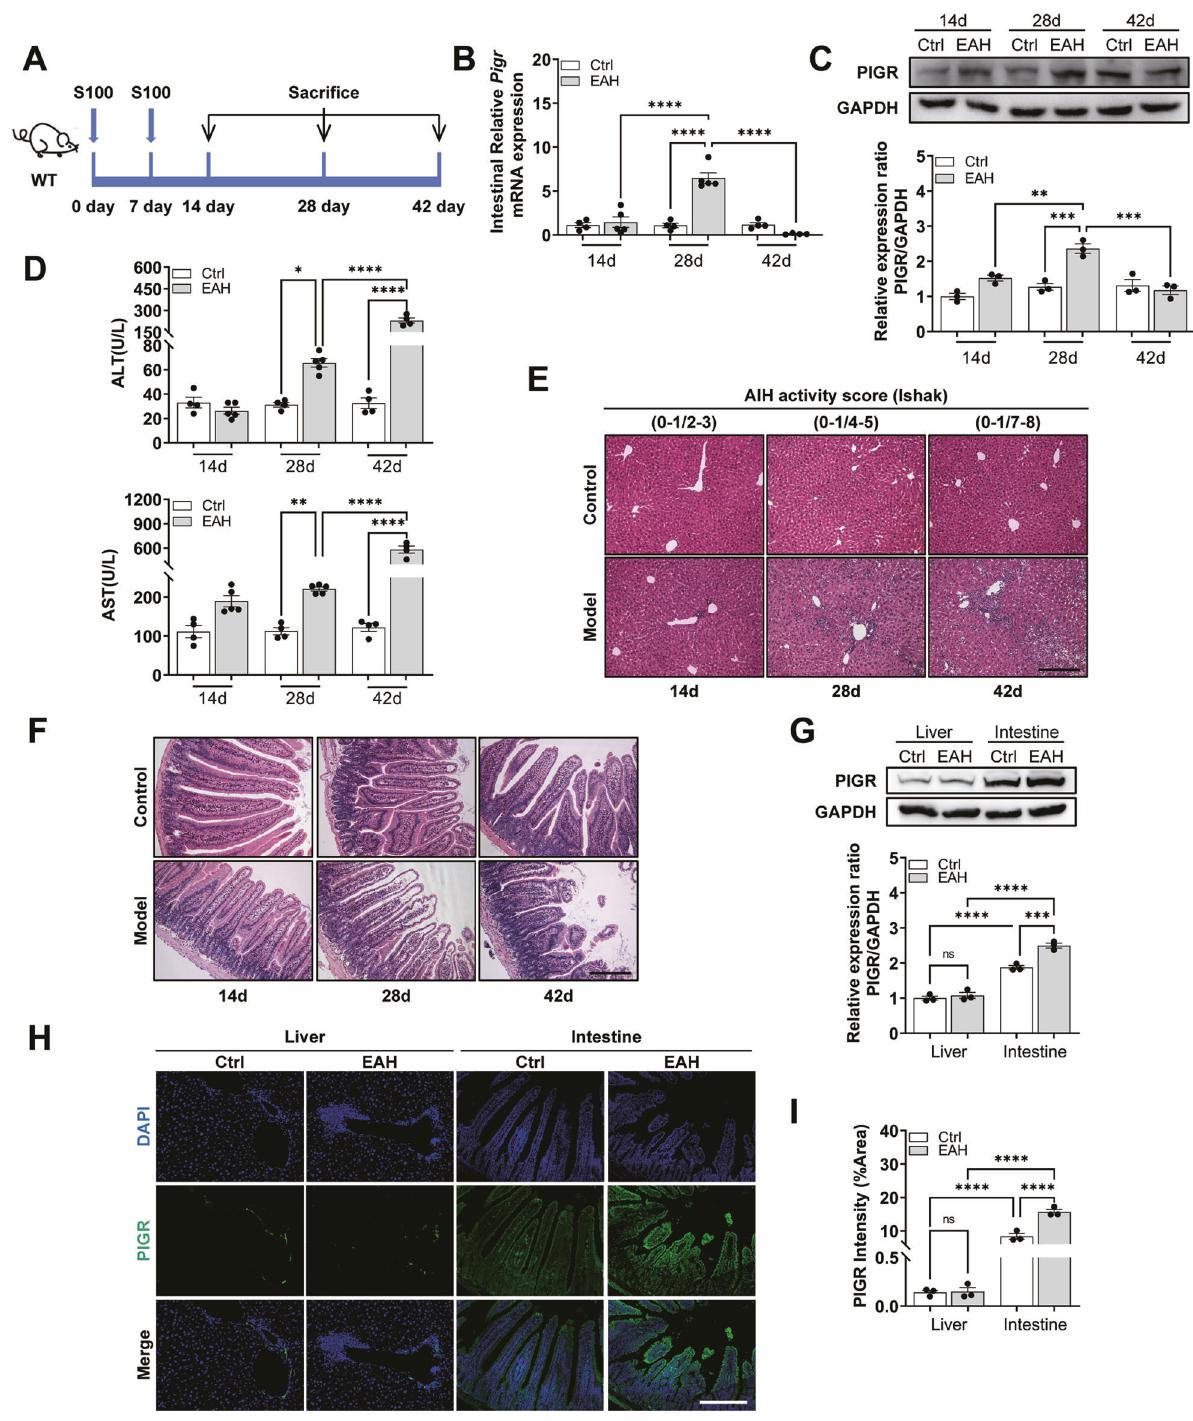
Fig. 1 Polymeric immunoglobulin receptor (pIgR) level is strongly associated with disease development in experimental autoimmune hepatitis (EAH). A Wild-type (WT) mice were intraperitoneally injected with S100 on days 0 and 7 and euthanized on days 14, 28, and 42. B Pigr gene expression at different time points. C Western blotting analysis for intestinal pIgR normalized by GAPDH. D Changes in serum alanine aminotransferase (ALT) and aspartate aminotransferase (AST) in mice with time. E , F Hematoxylin and eosin (H&E) staining of the liver and intestine in mice. Scale bar = 200 μ m. G Western blotting analysis for intestinal and liver pIgR normalized by GAPDH. H , I Immuno fl uorescence (IF) staining and quanti fi cation of pIgR. Scale bar = 200 μ m. Data are presented as mean ± standard error of the mean (SEM). Statistical analysis was performed using one-way ANOVA with Tukey multiple